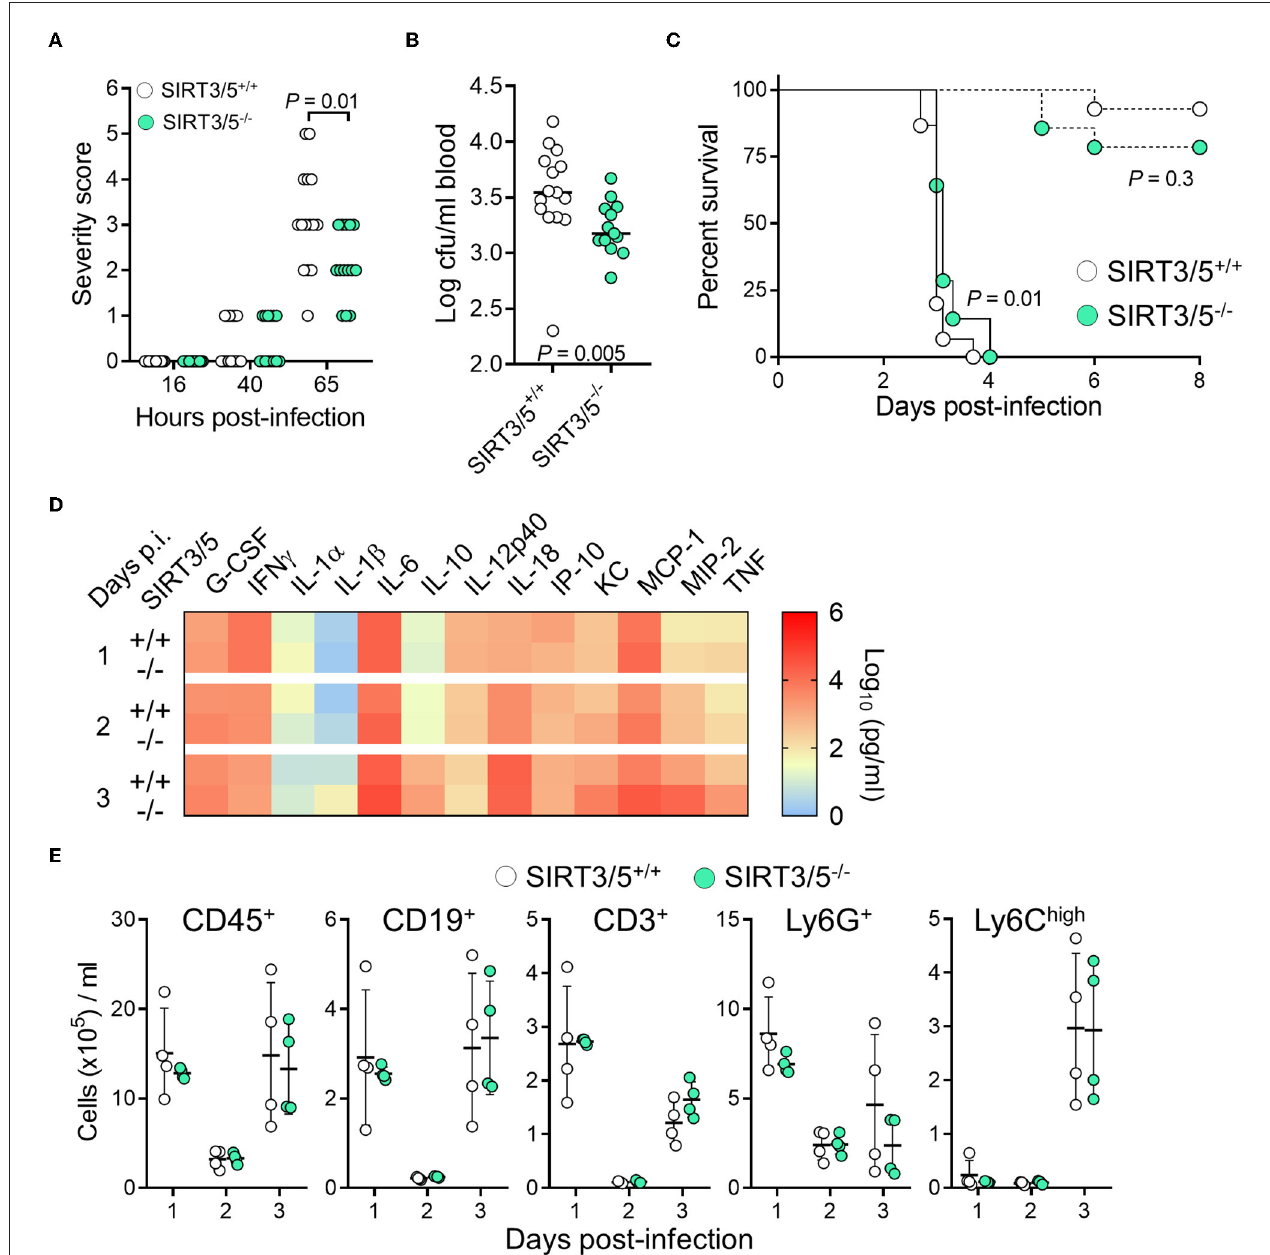
FIGURE 5 | SIRT3/5 deficiency confers some protection to listeriosis. (A–E) SIRT3/5 + / + and SIRT3/5 − / − mice ( n = 14–15 per group, aged 8–12 weeks) were injected intravenously with 7.3 × 10 3 cfu ( C , dashed lines) or 0.9–1.5 × 10 5 cfu L. monocytogenes ( A–E , plain lines in C ). (A) Severity scores were recorded. (B) L. monocytogenes in blood collected 2 days post-infection. (C) Survival of mice. (D) Cytokines, quantified by Luminex, in blood collected 1, 2, and 3 days post-infection (p.i.). The horizontal bar represents the median. Data are mean ± SD of four mice per group. P = 0.001 for TNF at day 1 p.i. 0.004 and 0.03 for TNF and IL-1 β at day 2 p.i. and 0.05 for KC at day 3 p.i. ENA-78, IL-3, IL-17A, and MIP-1 α were not detected. (E) CD45 + , CD19 + , CD3 + , Ly6G + and Ly6C high leukocytes in blood collected 1, 2, and 3 days post-infection. Each dot represents a mouse, and line and bars mean ±